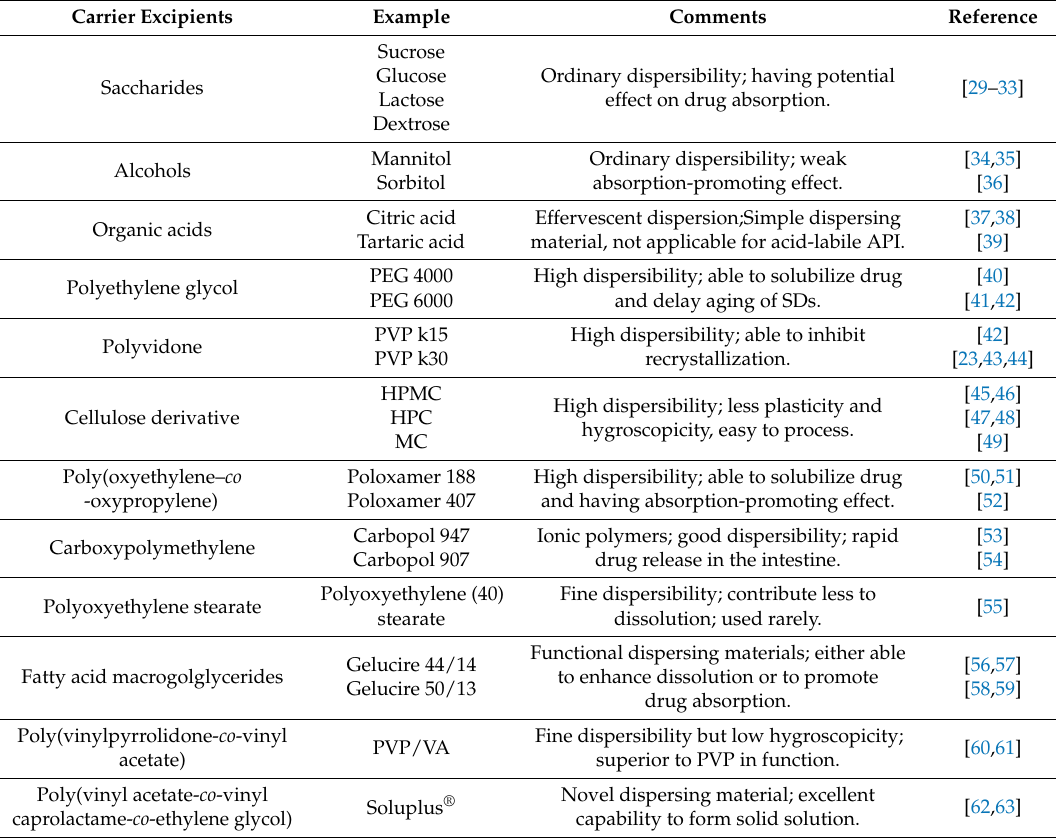
Table 1. Summary of the commonly used excipients for preparation of solid dispersions. Carrier